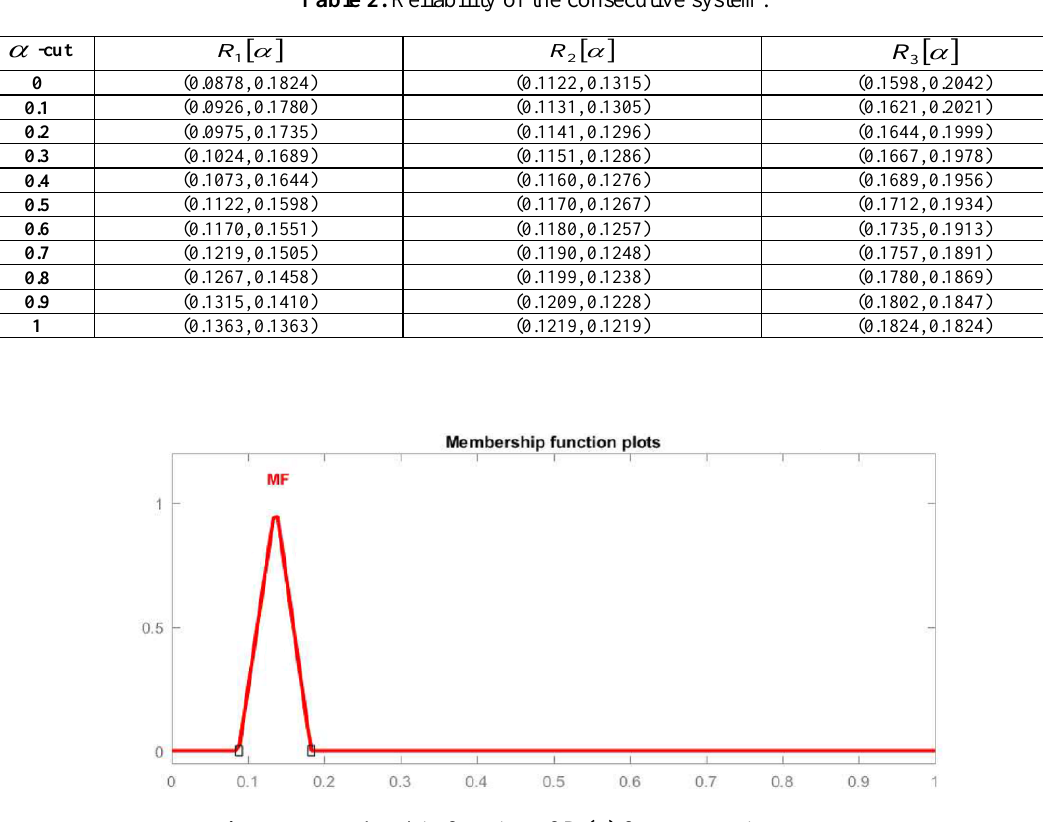
Figure 4. Membership function of R 1 ( α ) for consecutive